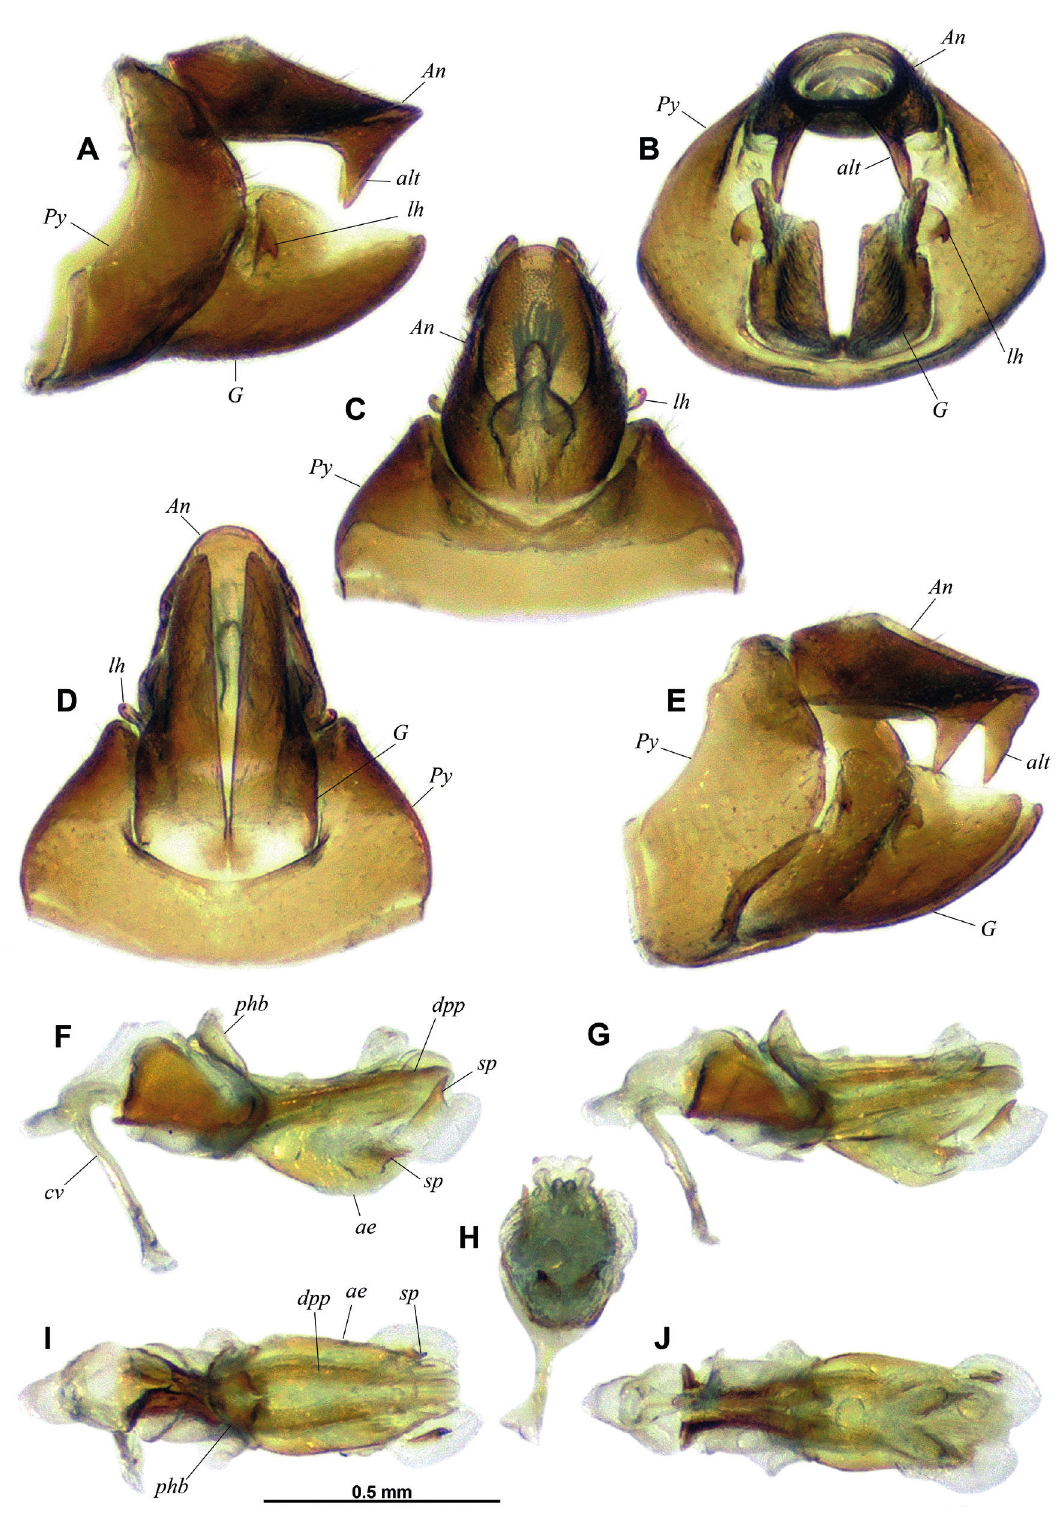
Fig. 9. Cleotyche ( Cleotyche ) francescoi sp. nov., ♂, holotype (QM). A–E . Pygofer, anal tube and gonostyli. A . Left lateral view. B . Caudal view. C . Dorsal view. D . Ventral view. E . Laterocaudal view. F–J . Aedeagus. F . Left lateral view. G . Dorsolateral view. H . Caudal view. I . Dorsal view. J . Ventral view. Abbreviations: see Fig.